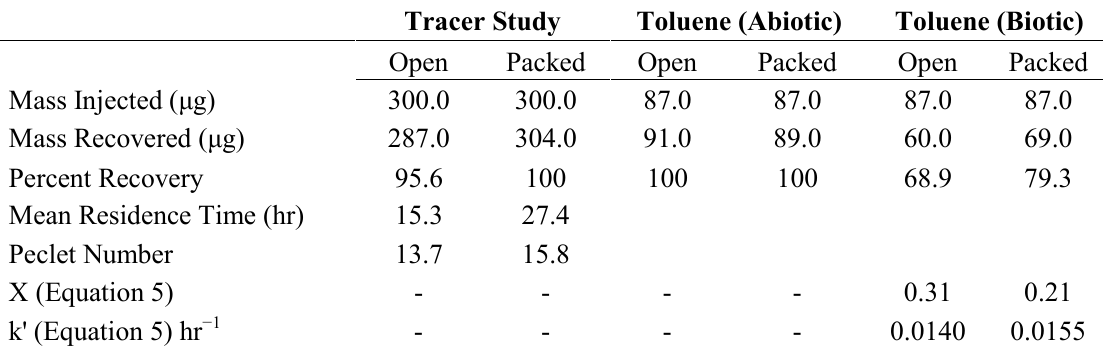
Table 1. Calculated results for tracer and toluene mass